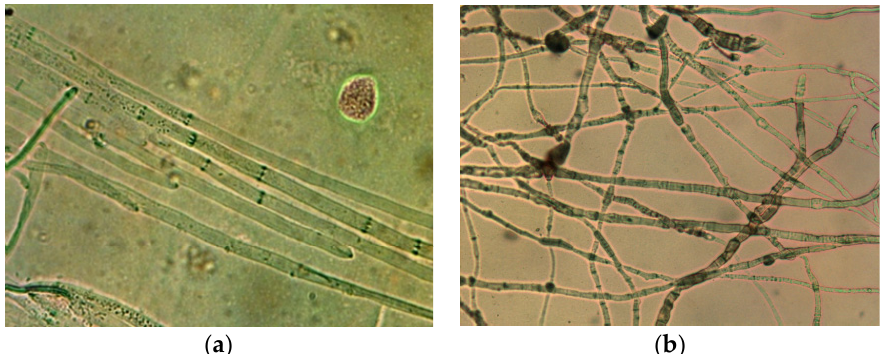
Figure 7. Types of F. graminearum BZR 4 damage: ( a )—gradual lysis of hyphae without shape loss; ( b )—degradation of hyphae by twisting, shortening, and curvature, ×400 magnification.